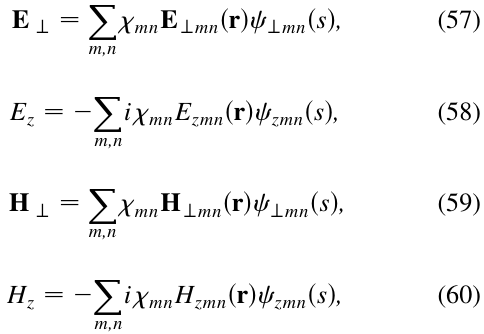
FIG. 8. (Color) Contours for integration in the k are two kinds of possible poles: dots corresponding to propagat- ing modes and crosses corresponding to decaying modes. The integral to be evaluated is defined on the line Re (cid:1) k lower-half plane, a little off the real axis, and its final result is obtained by letting (cid:11) ! 0 when the integration is finished. The contour closing in the upper-half plane is for s (cid:4) vt (cid:5) (cid:1) z (cid:5) (cid:2) > 0 , while the contour closing in the lower-half plane is for z 0 s < 0